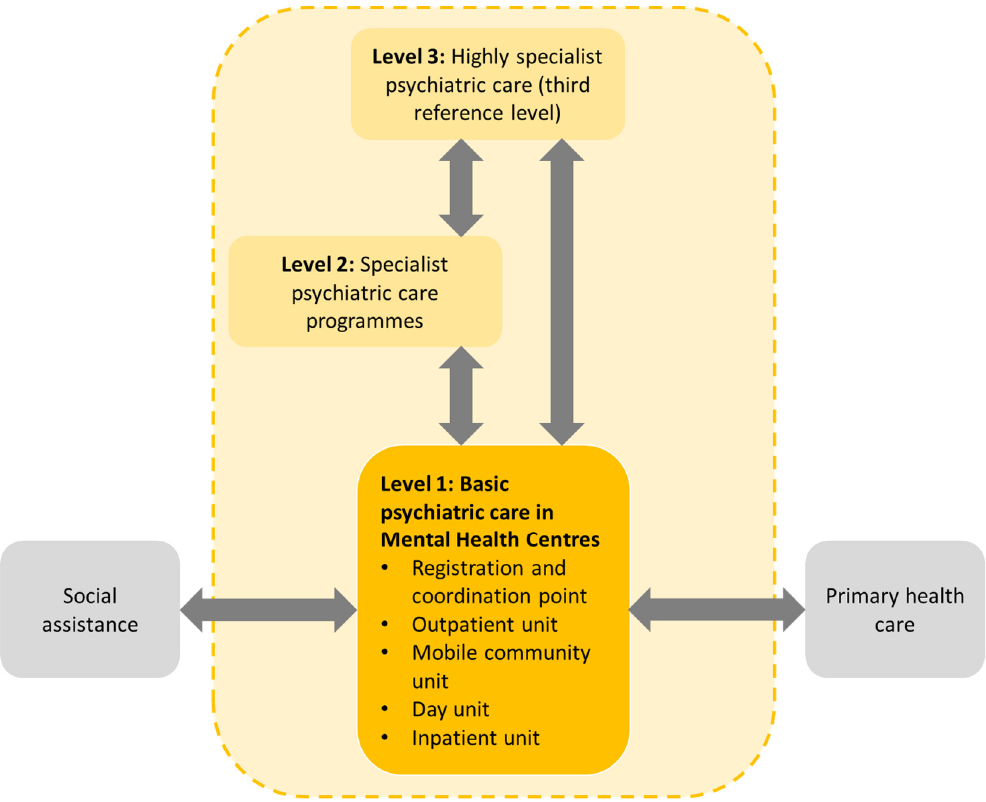
Figure 1. Organization of the mental health centre model of community mental care. Source: authors based on [28].